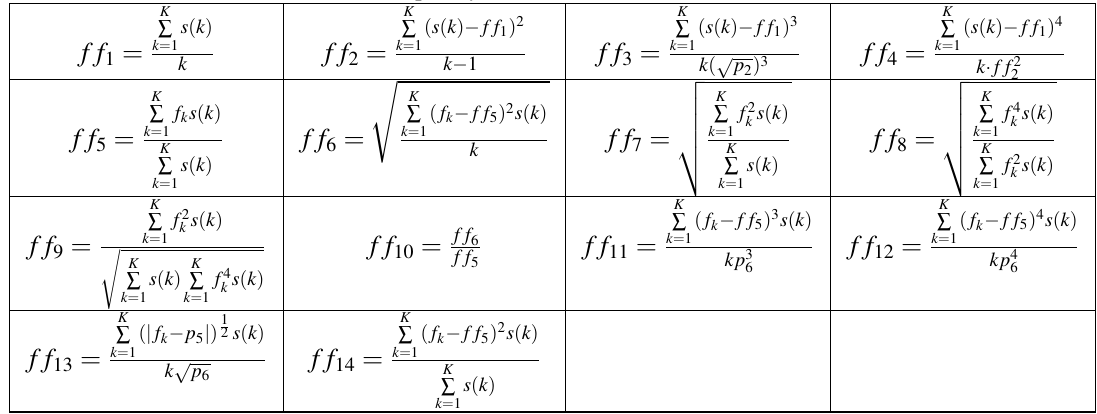
Table 2 Frequency-domain statistical